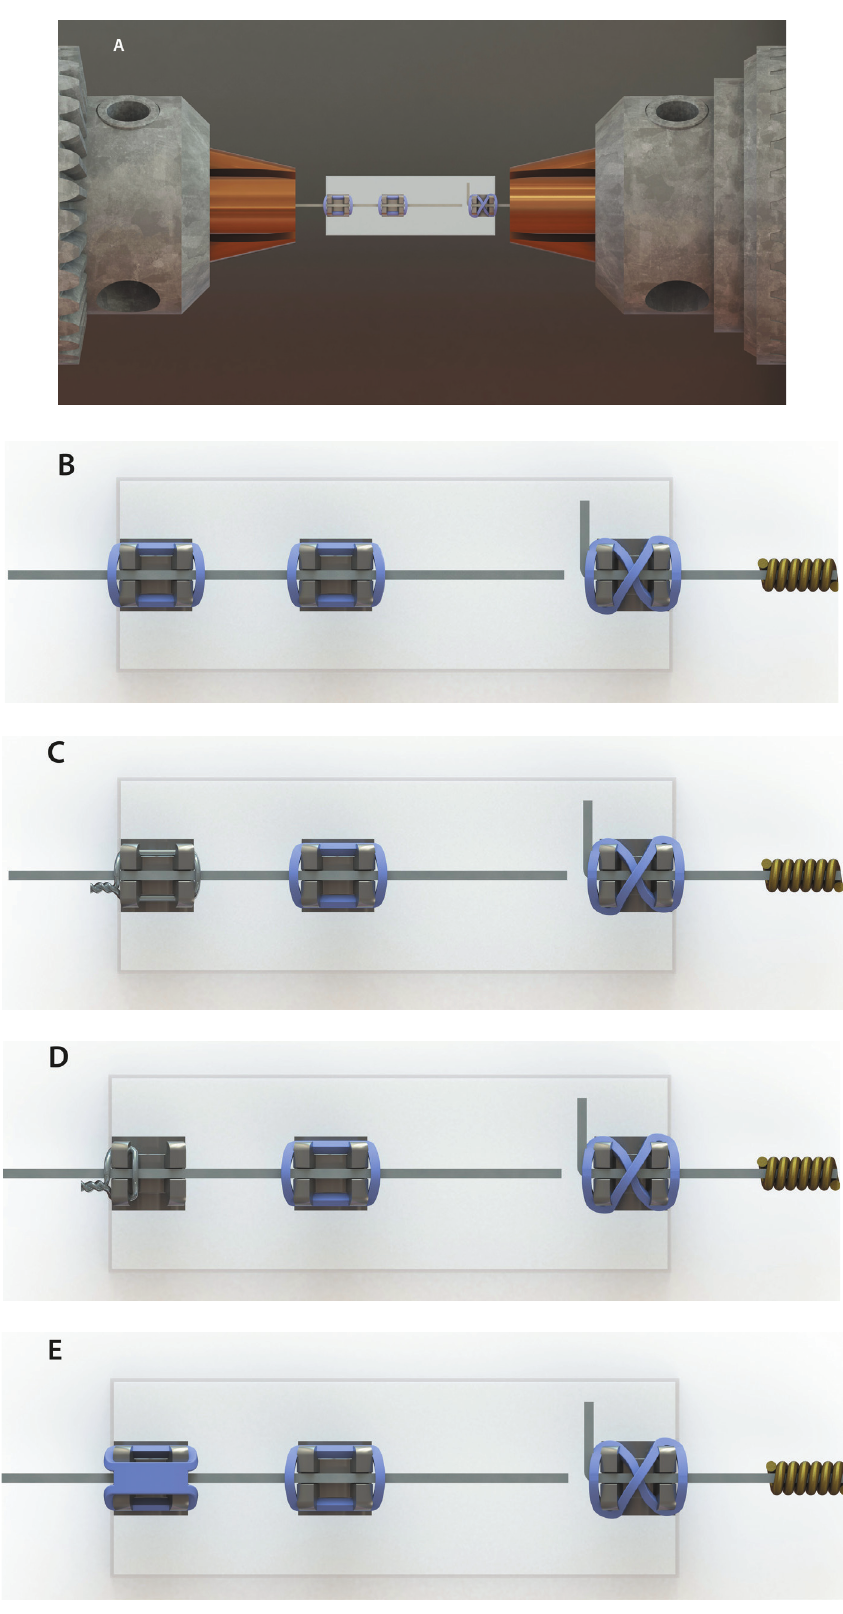
Figure 1- Graphic representation of the device developed to attach the samples to the universal testing machine presenting all brackets aligned and ready for testing and illustration of the methods of ligation tested. (A) Overall view of the apparatus; (B) Elastic ligature tied to the 4 bracket wings; (C) Steel ligature tied to all 4 bracket wings; (D) Steel ligature tied to 2 bracket wings; and (E) Ligation with Slide ® elastic